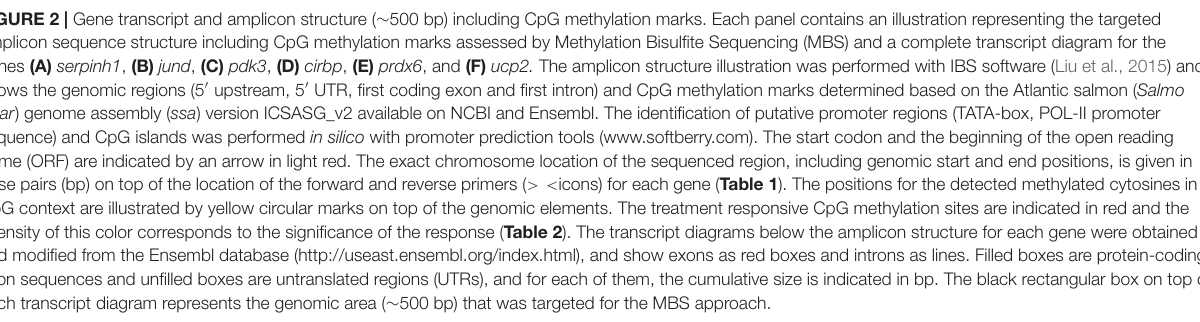
FIGURE 2 | Gene transcript and amplicon structure ( ∼ 500 bp) including CpG methylation marks. Each panel contains an illustration representing the targeted amplicon sequence structure including CpG methylation marks assessed by Methylation Bisulfite Sequencing (MBS) and a complete transcript diagram for the genes (A) serpinh1 , (B) jund , (C) pdk3 , (D) cirbp , (E) prdx6 , and (F) ucp2. The amplicon structure illustration was performed with IBS software (Liu et al., 2015) and shows the genomic regions (5 (cid:48) upstream, 5 (cid:48) UTR, first coding exon and first intron) and CpG methylation marks determined based on the Atlantic salmon ( Salmo salar ) genome assembly ( ssa ) version ICSASG_v2 available on NCBI and Ensembl. The identification of putative promoter regions (TATA-box, POL-II promoter sequence) and CpG islands was performed in silico with promoter prediction tools (www.softberry.com). The start codon and the beginning of the open reading frame (ORF) are indicated by an arrow in light red. The exact chromosome location of the sequenced region, including genomic start and end positions, is given in base pairs (bp) on top of the location of the forward and reverse primers ( > < icons) for each gene ( Table 1 ). The positions for the detected methylated cytosines in a CpG context are illustrated by yellow circular marks on top of the genomic elements. The treatment responsive CpG methylation sites are indicated in red and the intensity of this color corresponds to the significance of the response ( Table 2 ). The transcript diagrams below the amplicon structure for each gene were